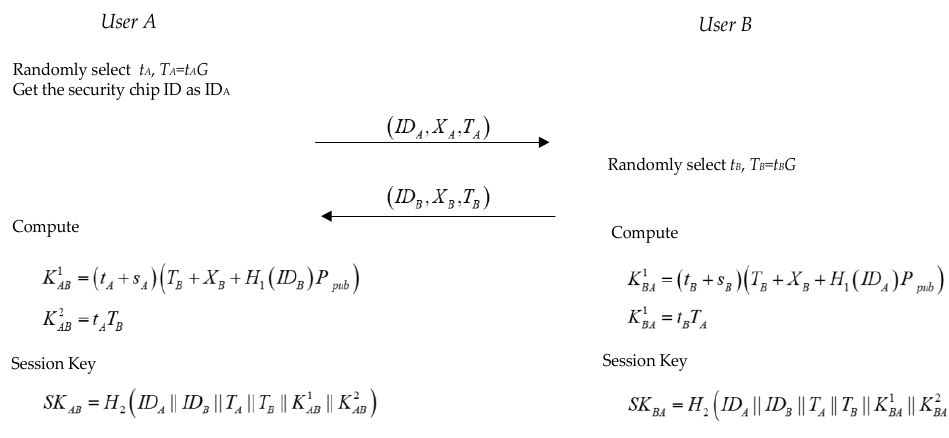
Figure 1. The processes of the proposed scheme.